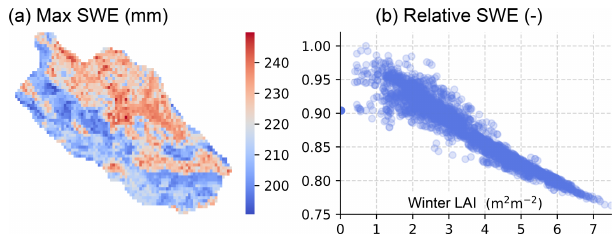
Figure 11. Spatial variability of maximum snow water equivalent (SWE) at C3 (a) . The SWE relative to open area scales near-linearly with wintertime leaf-area index LAI (b)